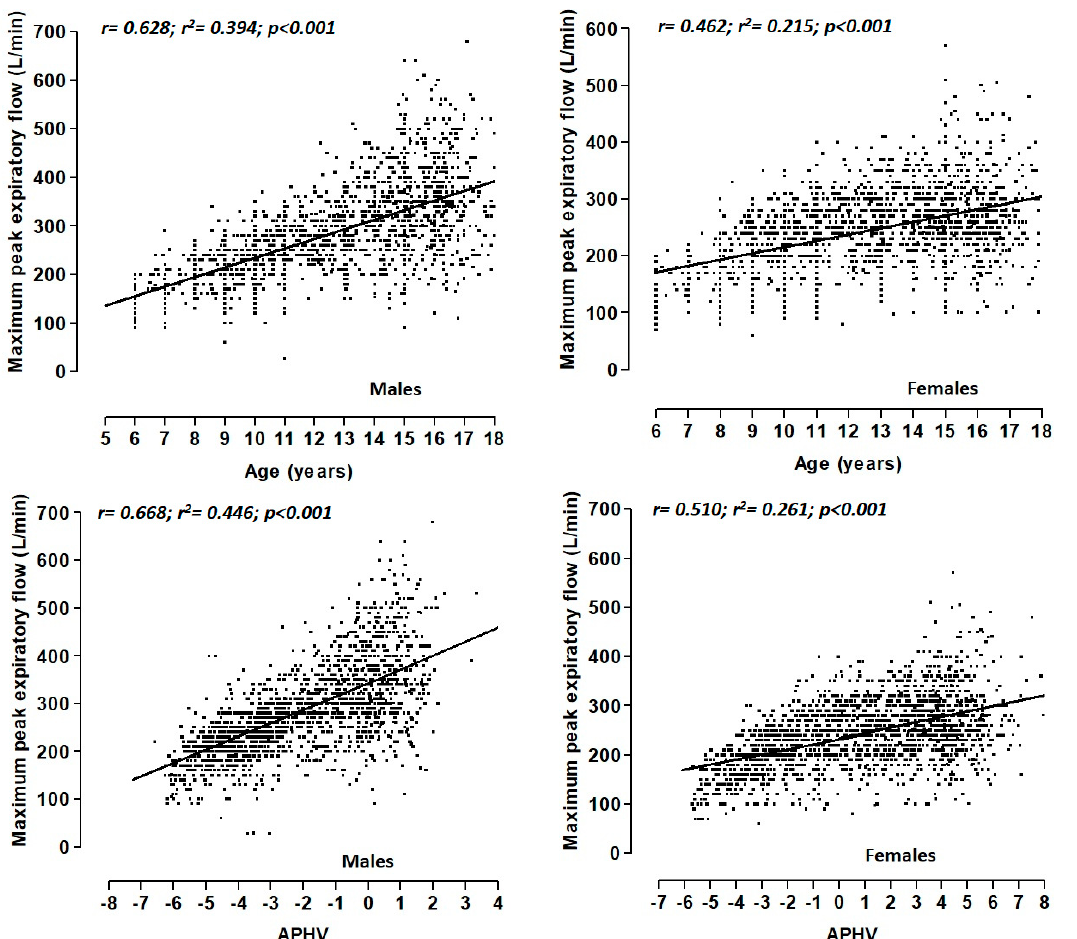
Figure 2. Relationship of the MEF with chronological age (years) and state of maturation (APHV) for both sexes, showing the line of best fit to the point cloud.